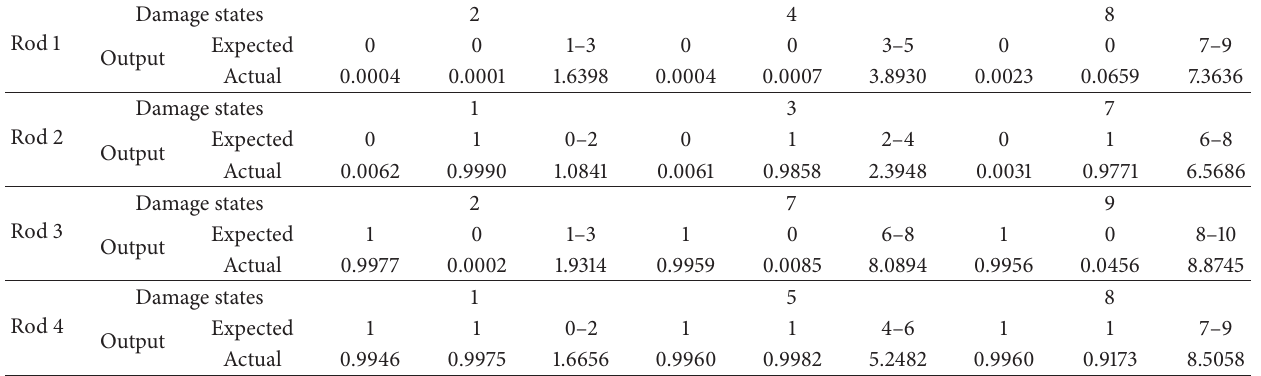
Table 1: Expected outputs and actual outputs of testing